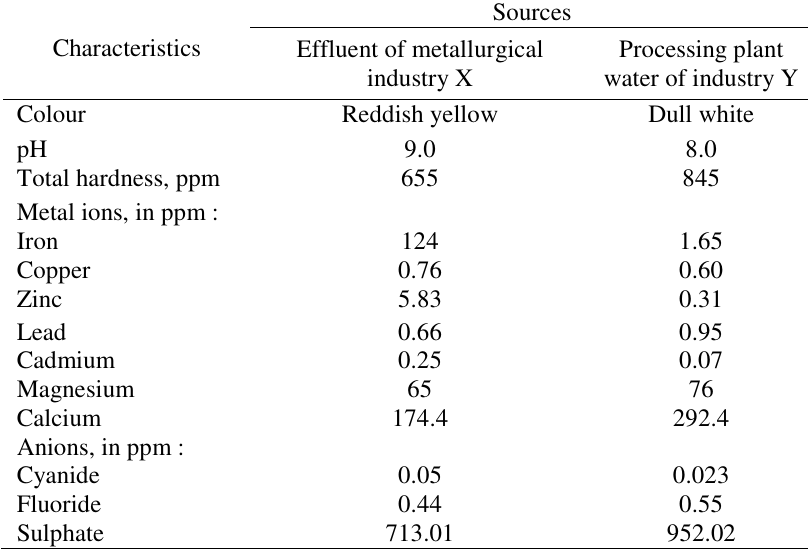
Table 4. Characteristics of effluents contaminated with heavy metal ions obtained from various units of mineral and metal processing industries